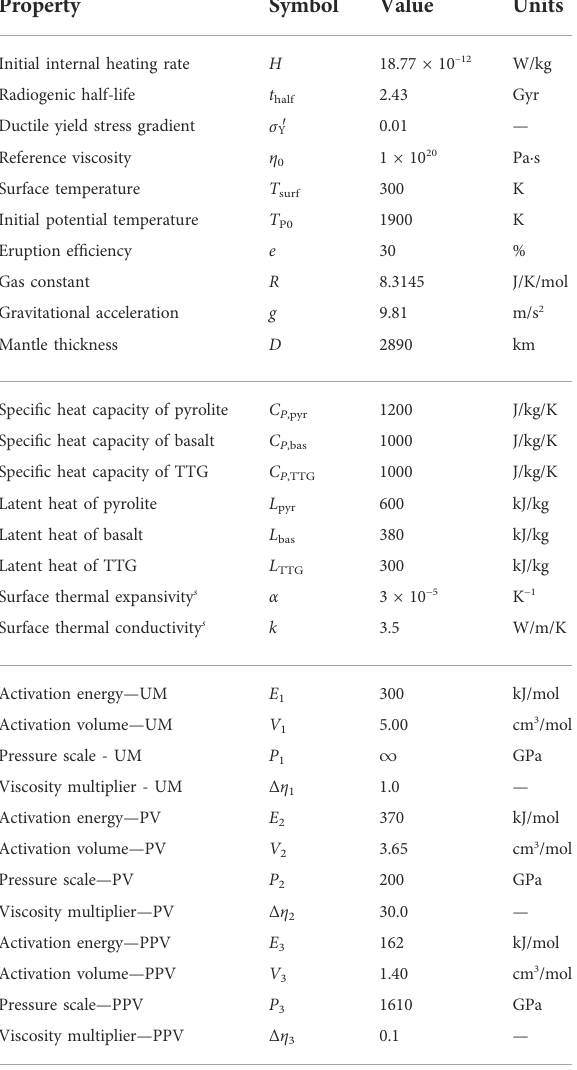
TABLE1Non-dimensionalanddimensionalparametersalongwiththe rheological properties for 3 different layers i used in this study (UM = Upper Mantle (dry olivine); PV = Perovskite; PPV = Post- Perovskite). TTG = tonalite-trondhjemite-granodiorite.